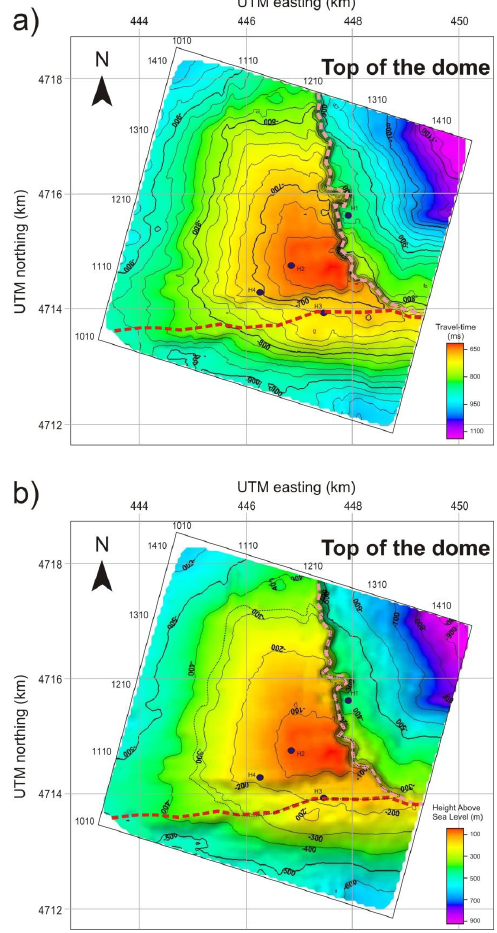
FIG. 15: (a) Time and (b) depth surface (replacement velocity of 3500 m/s) of the top of Fig. 15. (a) Time and (b) depth surface (replacement velocity of the Jurassic featuring the target dome structure, with the approximate position of 3500ms − 1 ) of the top of the Jurassic featuring the target dome Southern (red dashed line) and Eastern (pink dashed line) faults. structure, with the approximate position of southern (red dashed line) and eastern (pink dashed line) faults. The black dotted line indicates the area of the dome considered for the capacity estima-